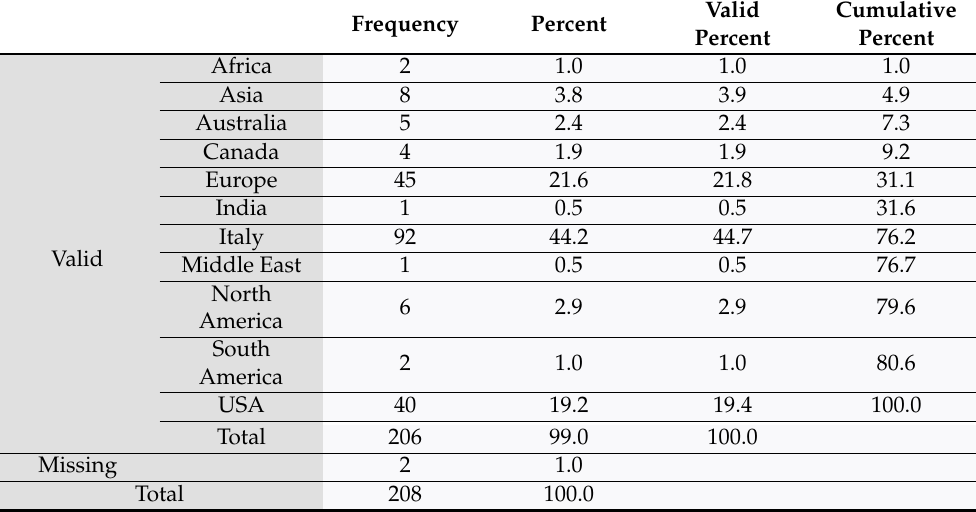
Table 2. Where do you